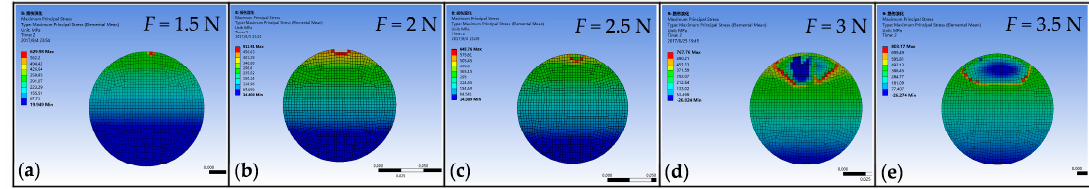
Figure 8. The maximum principal stress maps and crack shapes for five loads ( F = 1.5, 2, 2.5, 3, 3.5 N) at 18,999 h. ( a ) F = 1.5 N; ( b ) F = 2 N; ( c ) F = 2.5 N; ( d ) F = 3 N; ( e ) F = 3.5